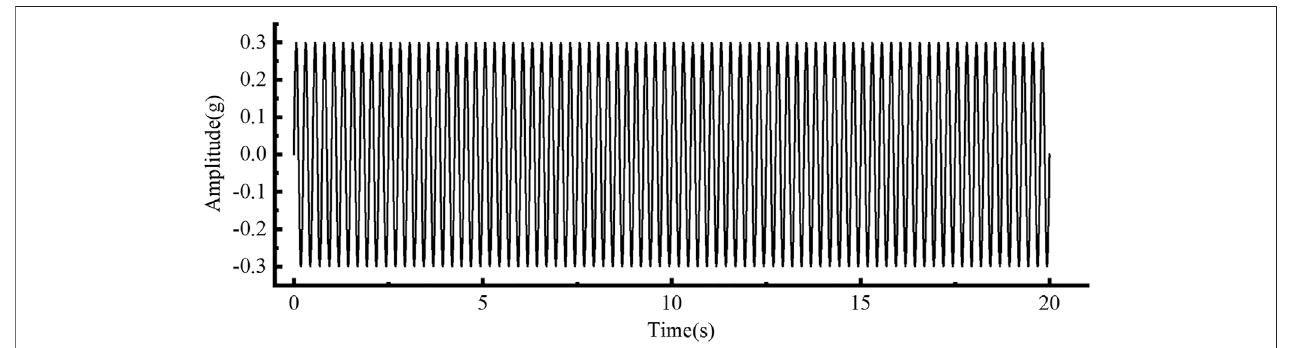
FIGURE 6 | Harmonic waves used as input base excitations.